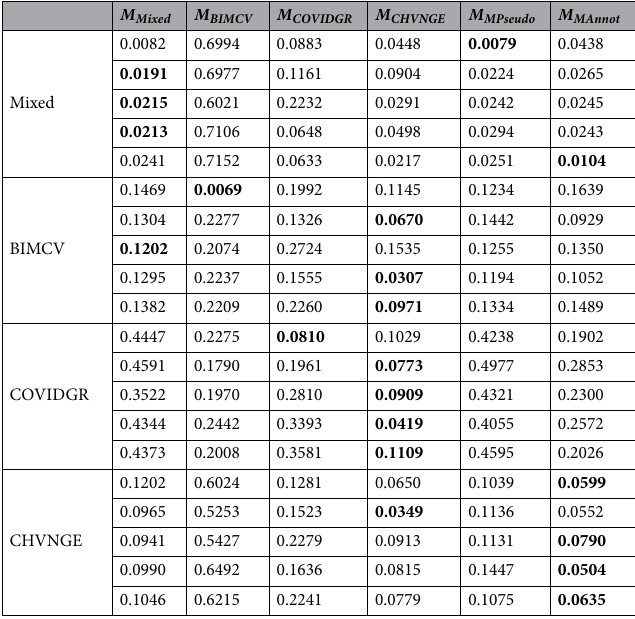
Table 7. Calibration in termos of ECE for each model and dataset for the 5 test folds. Lower ECE values indicate higher calibration. Bold indicates lowest value in